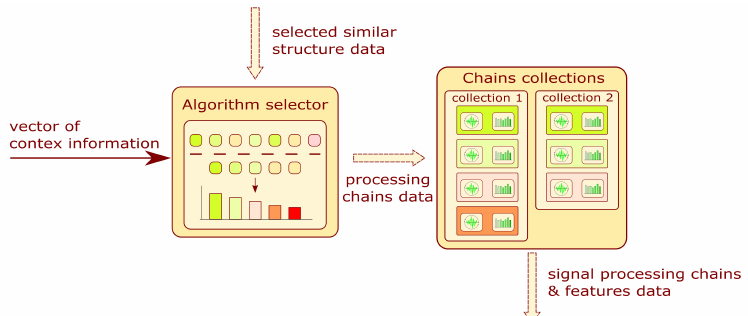
Figure 6. Block diagram of signal processing and feature selector module.